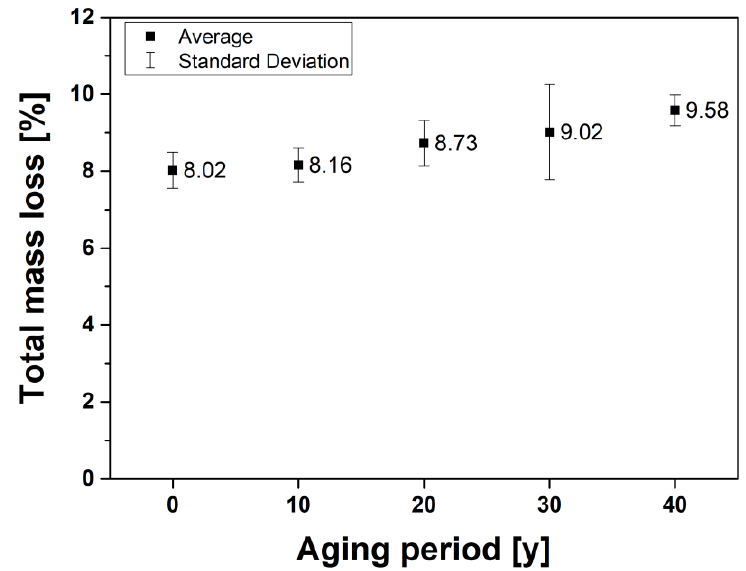
Figure 8. Total mass loss with respect to the accelerated aging periods.